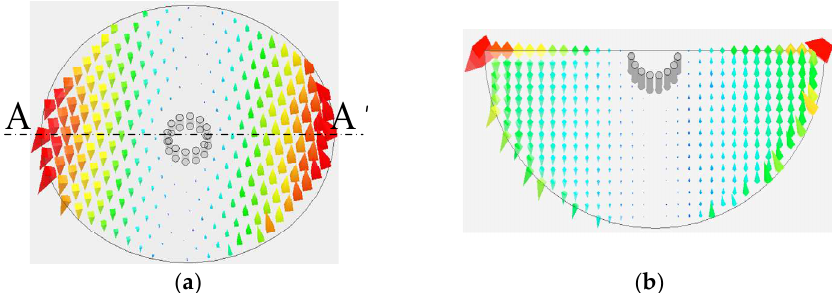
Figure 3. Electric field distributions of the TM110 mode of the two patch resonators. ( a ) Circular patch resonator; ( b ) semicircular patch resonator.